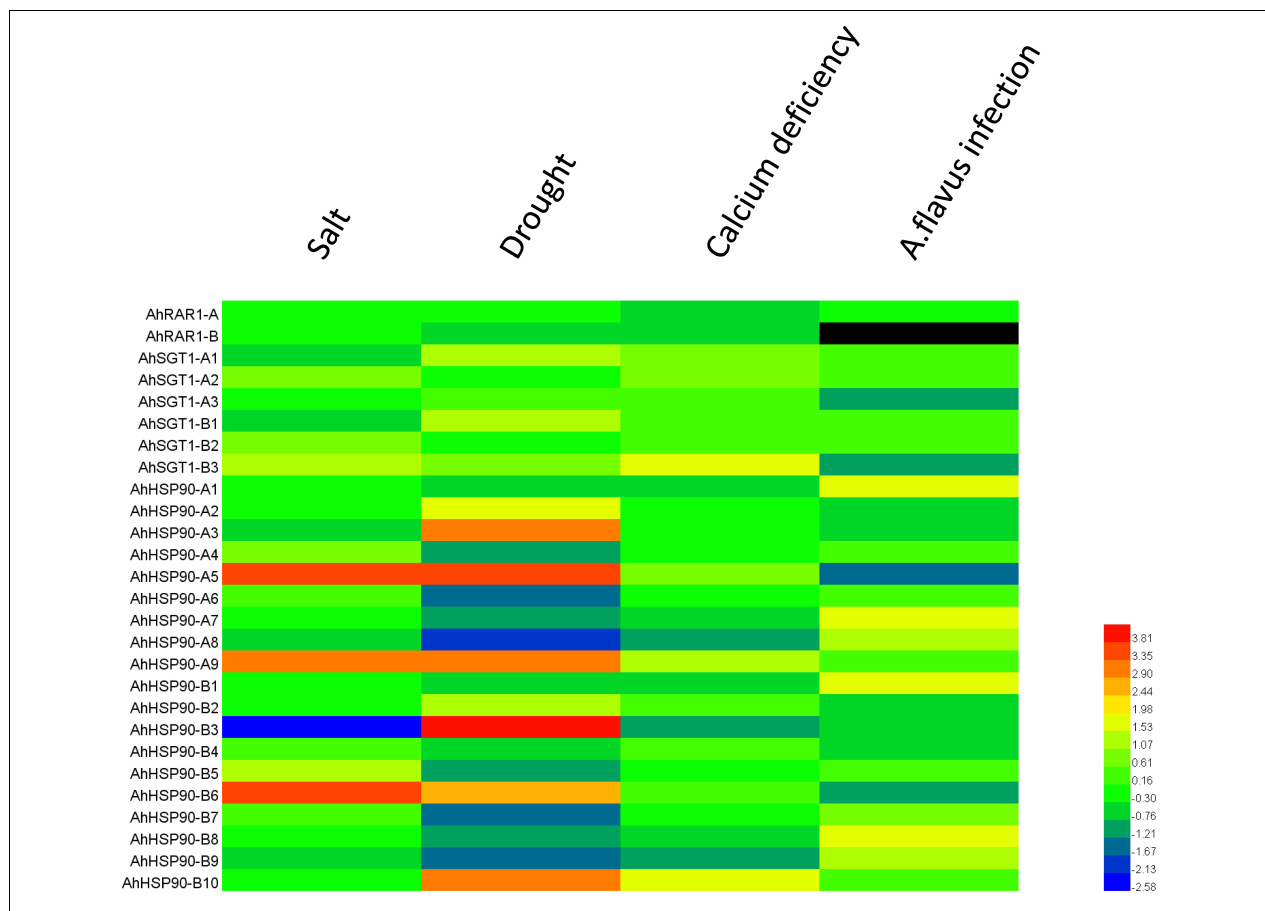
FIGURE 8 | Transcriptome analysis of HRS genes in response to different stresses. The FPKM data of each gene under salt, drought, calcium deficiency, and Aspergillus flavus infection were sourced from previous studies (Zhao et al., 2018, 2020; Chen et al., 2019; Zhang et al., 2020). The fold change in HRS gene expression under stress treatment compared to that under control treatment was normalized, log2-transformed and displayed in the form of a heatmap by HemI. The color scale in the lower right indicates relative expression level: green represents a low level, and red indicates a high level. The 22 different tissues are listed at the top of the heat map. The HRS genes are listed on the left of the heatmap. The color scale in the lower right indicates relative expression level: green represents a low level, and red indicates a high level. Different stress treatments are shown along the top of the heat map. The HRS genes are listed on the left of the